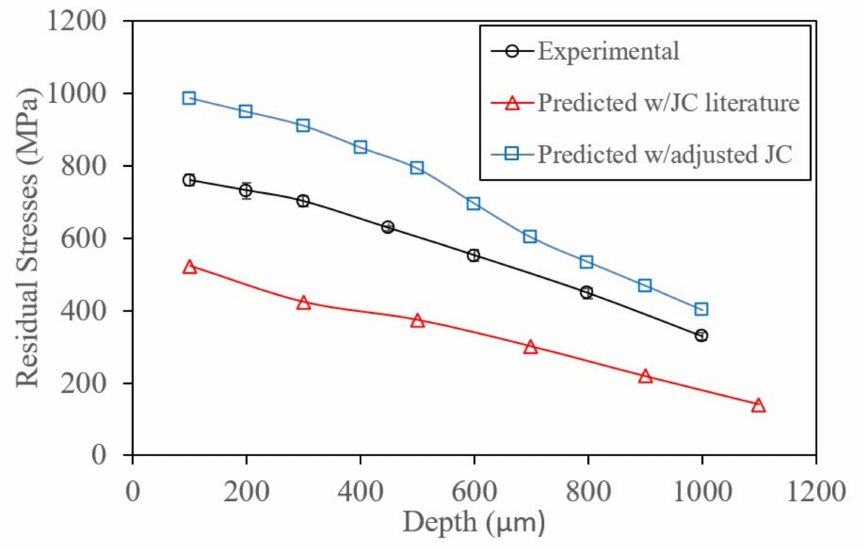
Figure 44. In-depth RS at 140 W, 650 mm/s, and 0.12